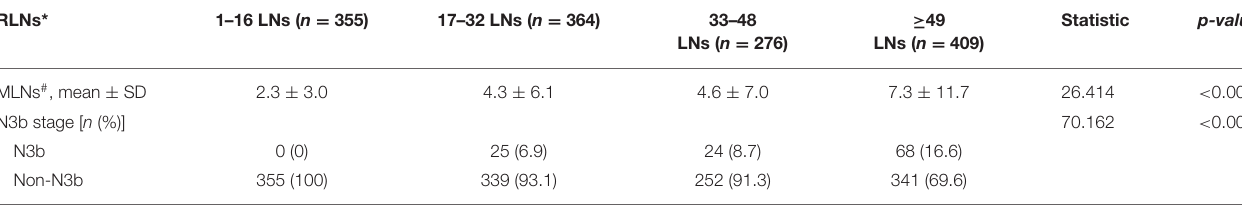
TABLE 3 | The number of metastatic lymph node and the dectecting of N3b status in the four groups with different retrieved lymph node.